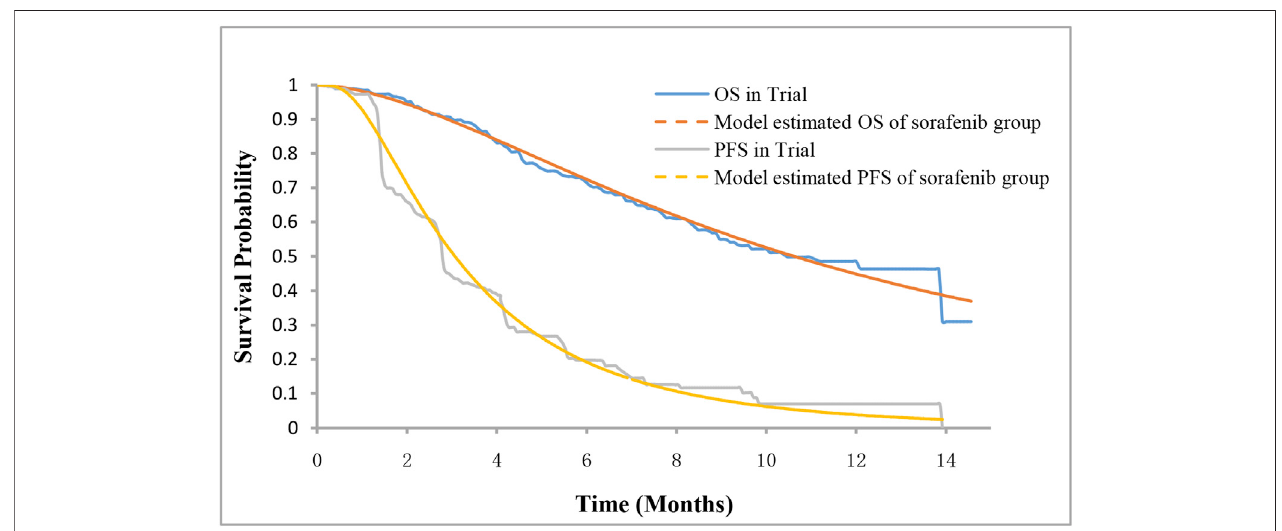
FIGURE 2 | Survival curves for model and the phase III trial. PFS, progression-free survival; OS, overall survival.